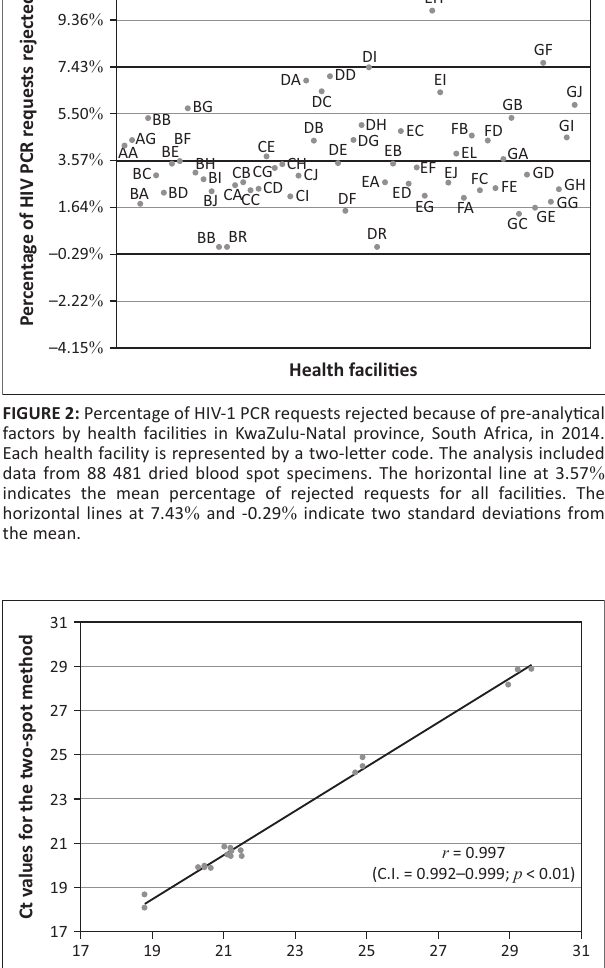
TABLE 3: Results of specimens tested by standard method and two-spot method in 2014 at the Department of Virology laboratory at Inkosi Albert Luthuli Central Hospital, KwaZulu-Natal province, South Africa. Result